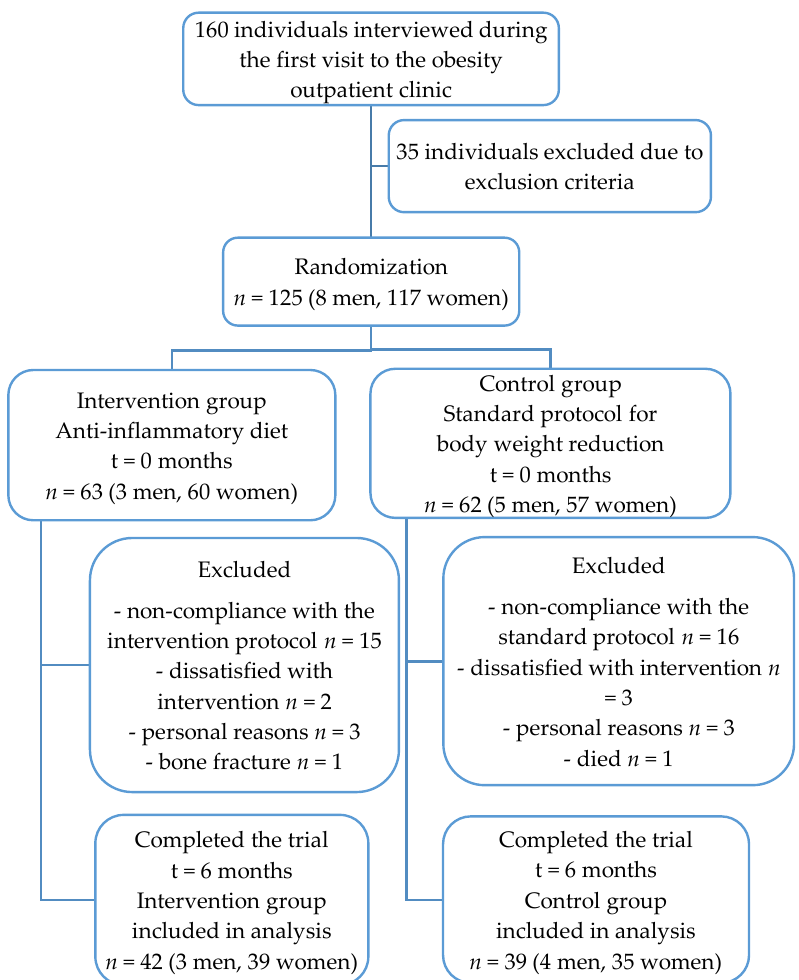
Figure 1. The flow diagram of participants included in the study.